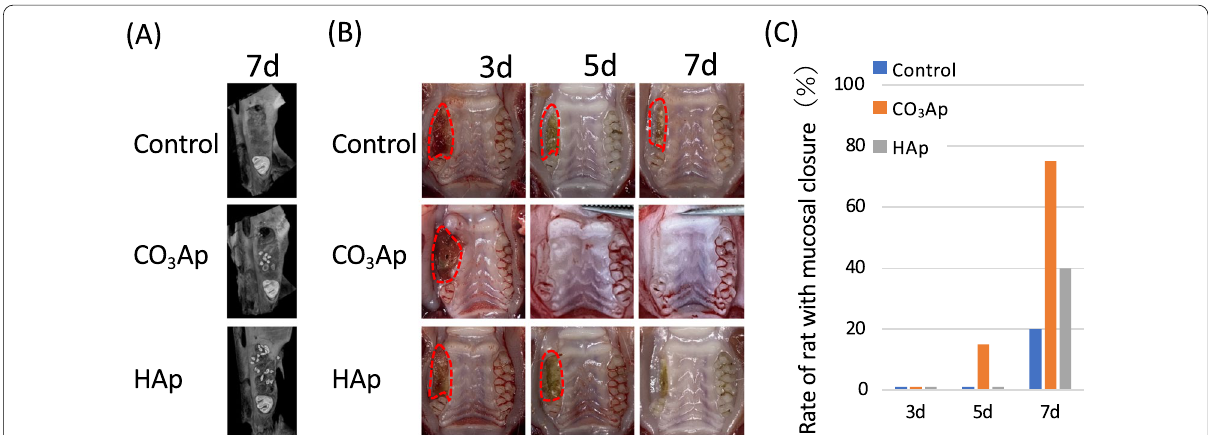
Fig. 4 Effect of carbonate apatite on soft tissue healing. A Image of the horizontal section at the observation site (schematic and CT image). B Soft tissue closure was observed macroscopically and over time on intra oral photographs after tooth extraction and material filling. C Percentage of mucosal closure (n 6) =